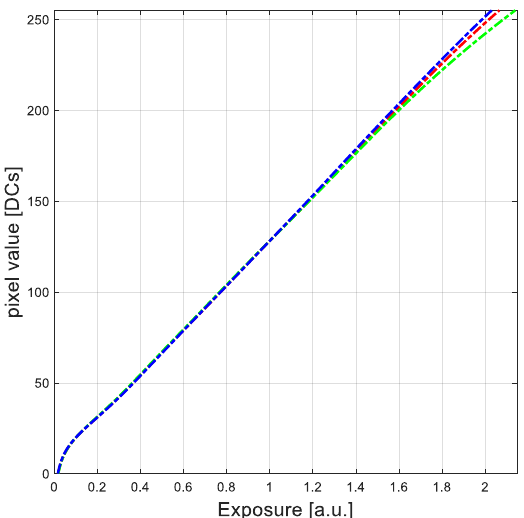
Figure 4. Sky-camera response function obtained for the three channels (RGB) using the weighting function in Equation (2).